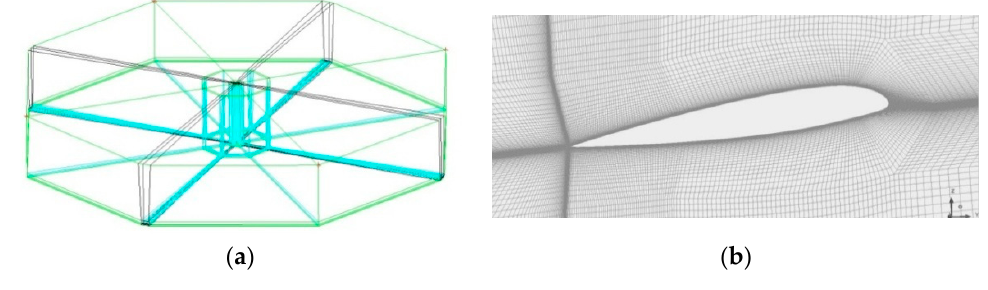
Figure 6. Multi-block topology ( a ) and mesh section ( b ).